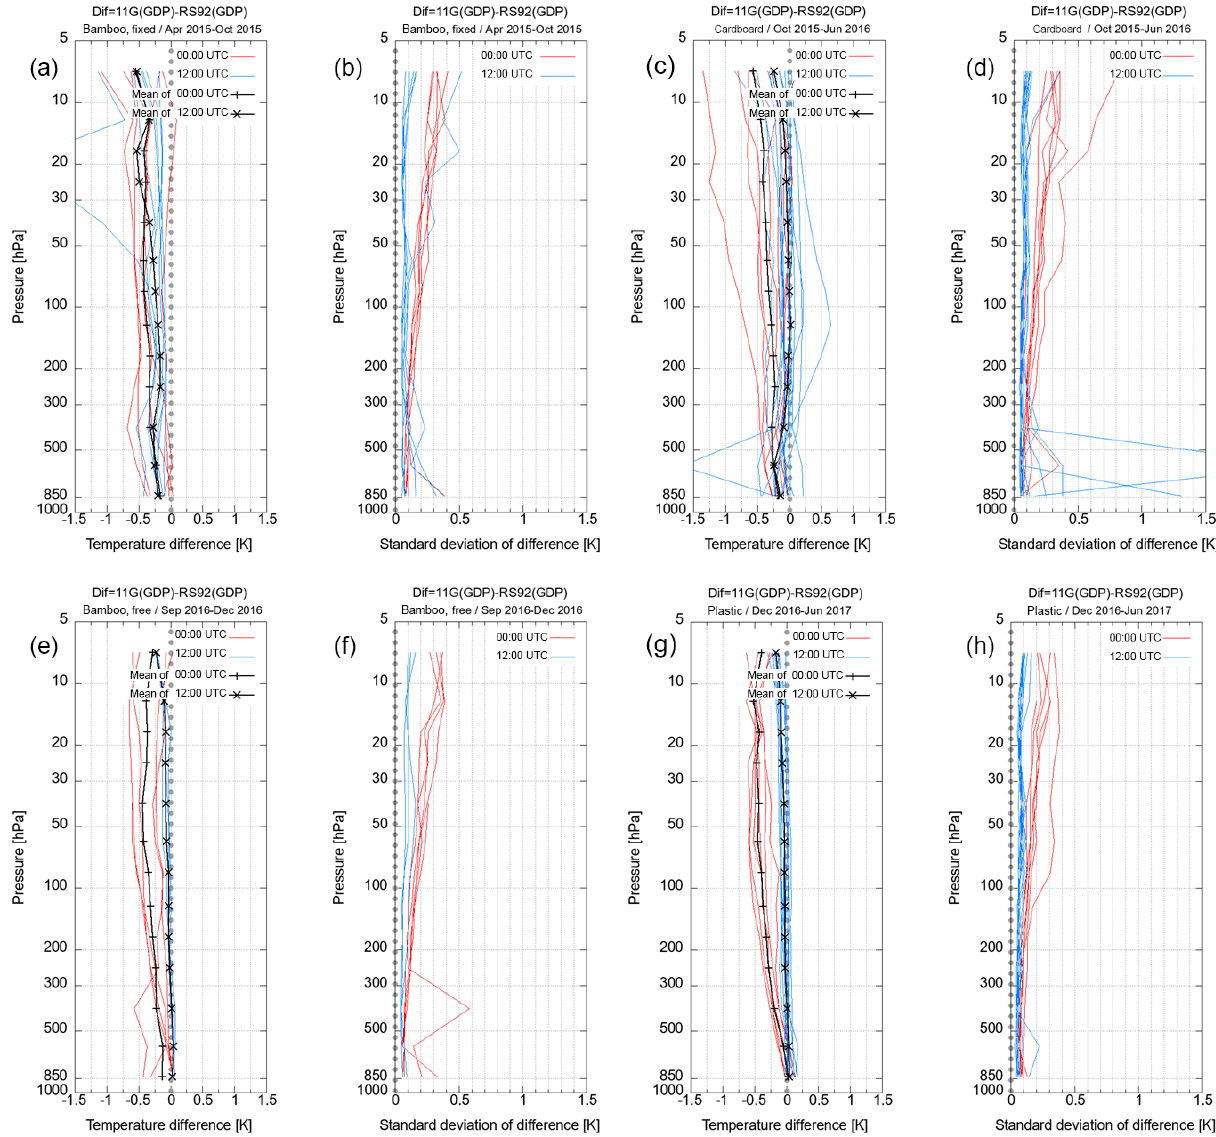
Figure 7. Temperature differences and standard deviation for four different rig configurations. The temperature data were allocated to four categories, i.e., bamboo rod with fixed radiosondes (a, b) , paper cardboard rod (c, d) , bamboo rod with radiosondes hanging freely (e, f) , and plastic cardboard rod (g, h) . Red and blue lines show the results in daytime and nighttime observations, respectively. Black lines show means of temperature differences for daytime (00:00UTC) and nighttime (12:00UTC)